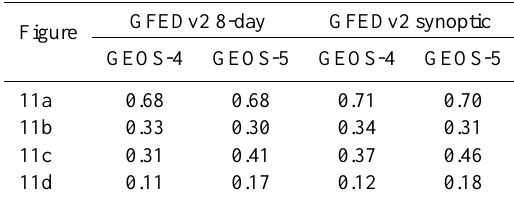
Table 2. Correlation coefficients between GEOS-Chem simulated and IMPROVE observed surface BC concentrations (Fig. 11).